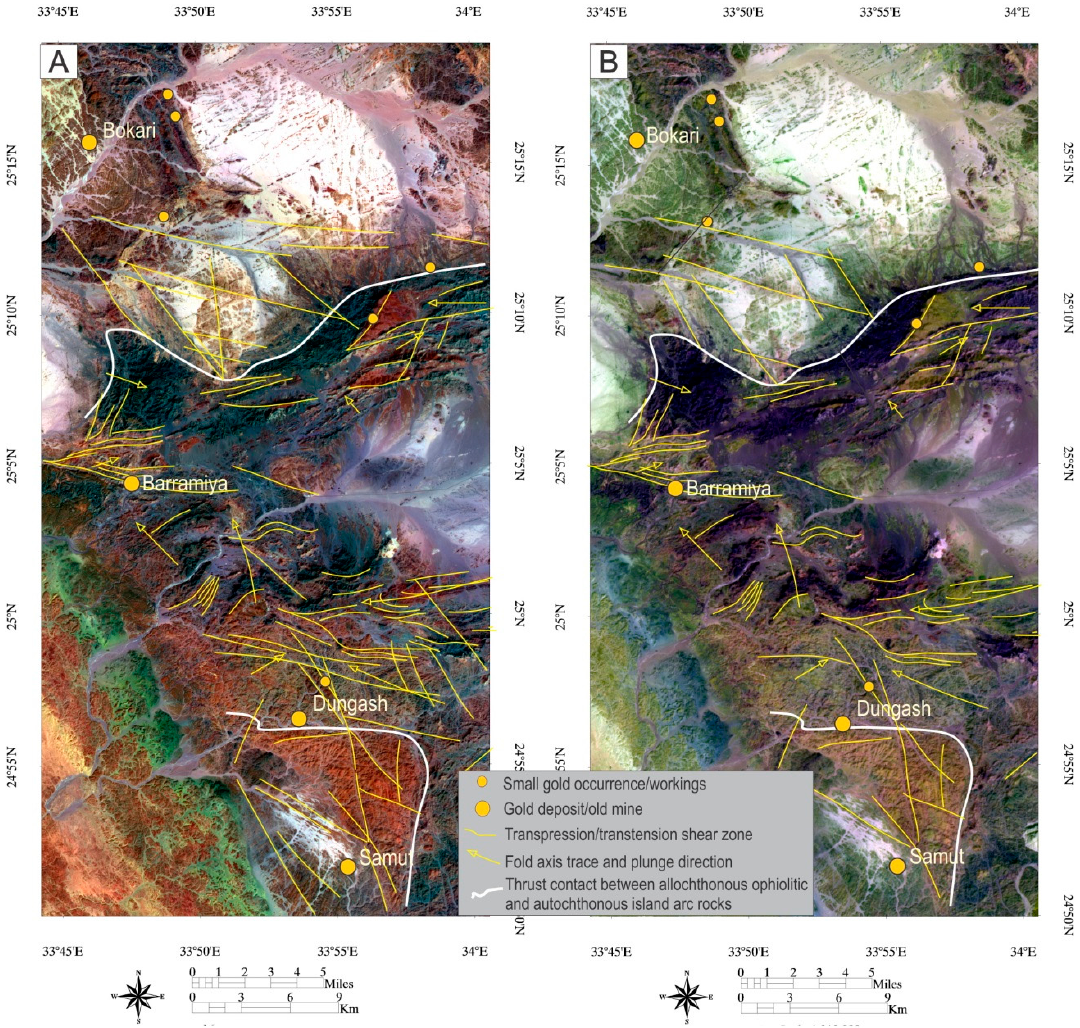
Figure 6. False-color composite, ASTER band combination images for the study area: ( A ) (R: Band 4, G: Band 3, B: Band 1) used to map Fe 2 O 3 / MgO-rich rocks, ( B ) (R: Band 4, G: Band 7, B: Band 3) used to enhance the signature of Al 2 O 3 -rich rocks to promote detailed mapping of the folded ophiolitic rocks.